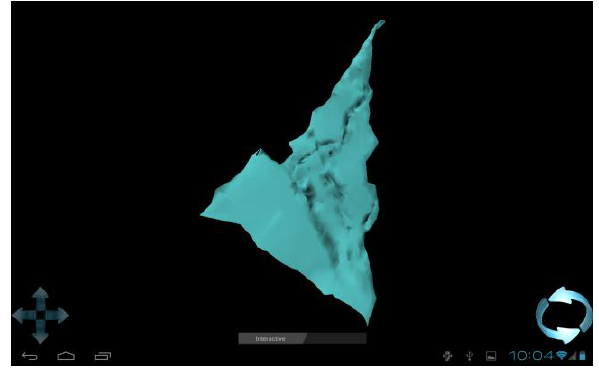
Figure 7: First view of digital dataset